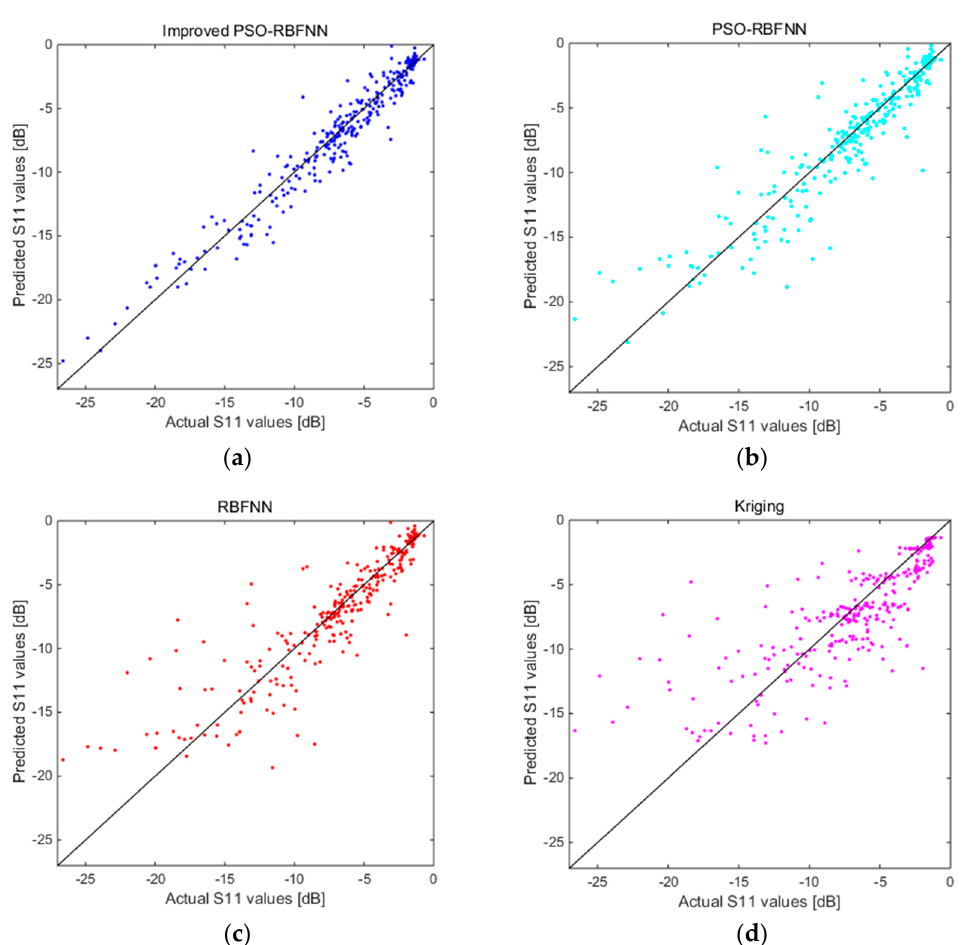
Figure 10. Comparison of actual S 11 values when using ( a ) Improved PSO-RBFNN, ( b ) PSO-RBFNN, ( c ) RBFNN, ( d ) Kriging surrogate models.